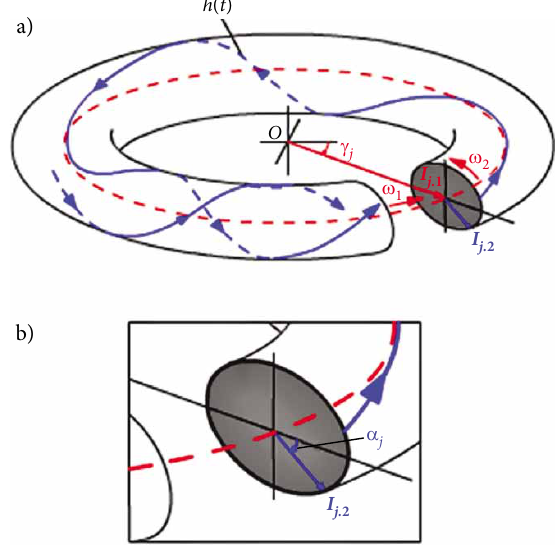
14 pav. Konservatyvios (nedisipatyvios) sistemos dvimatis energijos paviršius (toras) fazinėje erdvėje, aprašytas elgsenos , I , (cid:74) , (cid:68) : a – fazinė trajektorija h ( t ) toro kintamaisiais I j .1 j .2 j j paviršiuje; b – toro skerspjūvis ir elgsenos kintamieji I Fig. 14. Two-dimensional energy surface (torus) of the conservative (non-dissipative) system in phase space , I , (cid:74) , (cid:68) : a – phase expressed in behaviour variables I j .1 j .2 j j trajectory h ( t ) on torus surface; b – the torus section and and (cid:68) behaviour variables I j .2 j